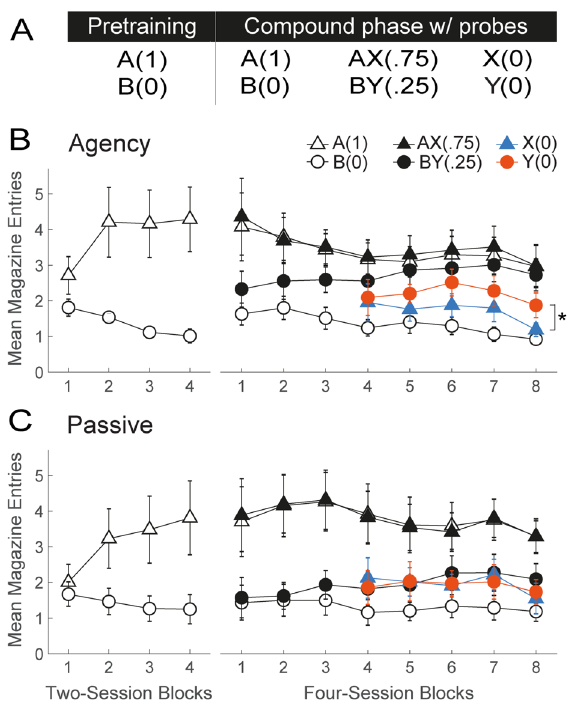
Figure 3. Agency over learning rescues competitive credit assignment under massed training conditions in the absence of an explicit configural solution. ( A ) Experimental design. The pretraining phase involved a simple discrimination between A(1) and B(0). During the compound phase, these trials continued to be presented, but were interleaved with AX(.75) and BY(.25) trials. Note that X has a higher probability of reward than Y. However, X signals a net decrement in the probability of reward when considered against the backdrop of A, whereas Y signals a net increase in the probability of reward when considered against the backdrop of B. Thus, to the extent credit assignment is competitive, Y should evoke more responding than X, but the opposite should be true if credit assignment is noncompetitive. To test this, two daily probe trials with X and Y were inter leaved with training trials, starting on session 13 of the Compound phase. ( B , C ) Behavioral results in groups Agency and Passive, respectively. The left and right line plots depict performance during the Pretraining and Compound phases, respectively. Conditioned responding is represented as mean number of magazine head entries (±